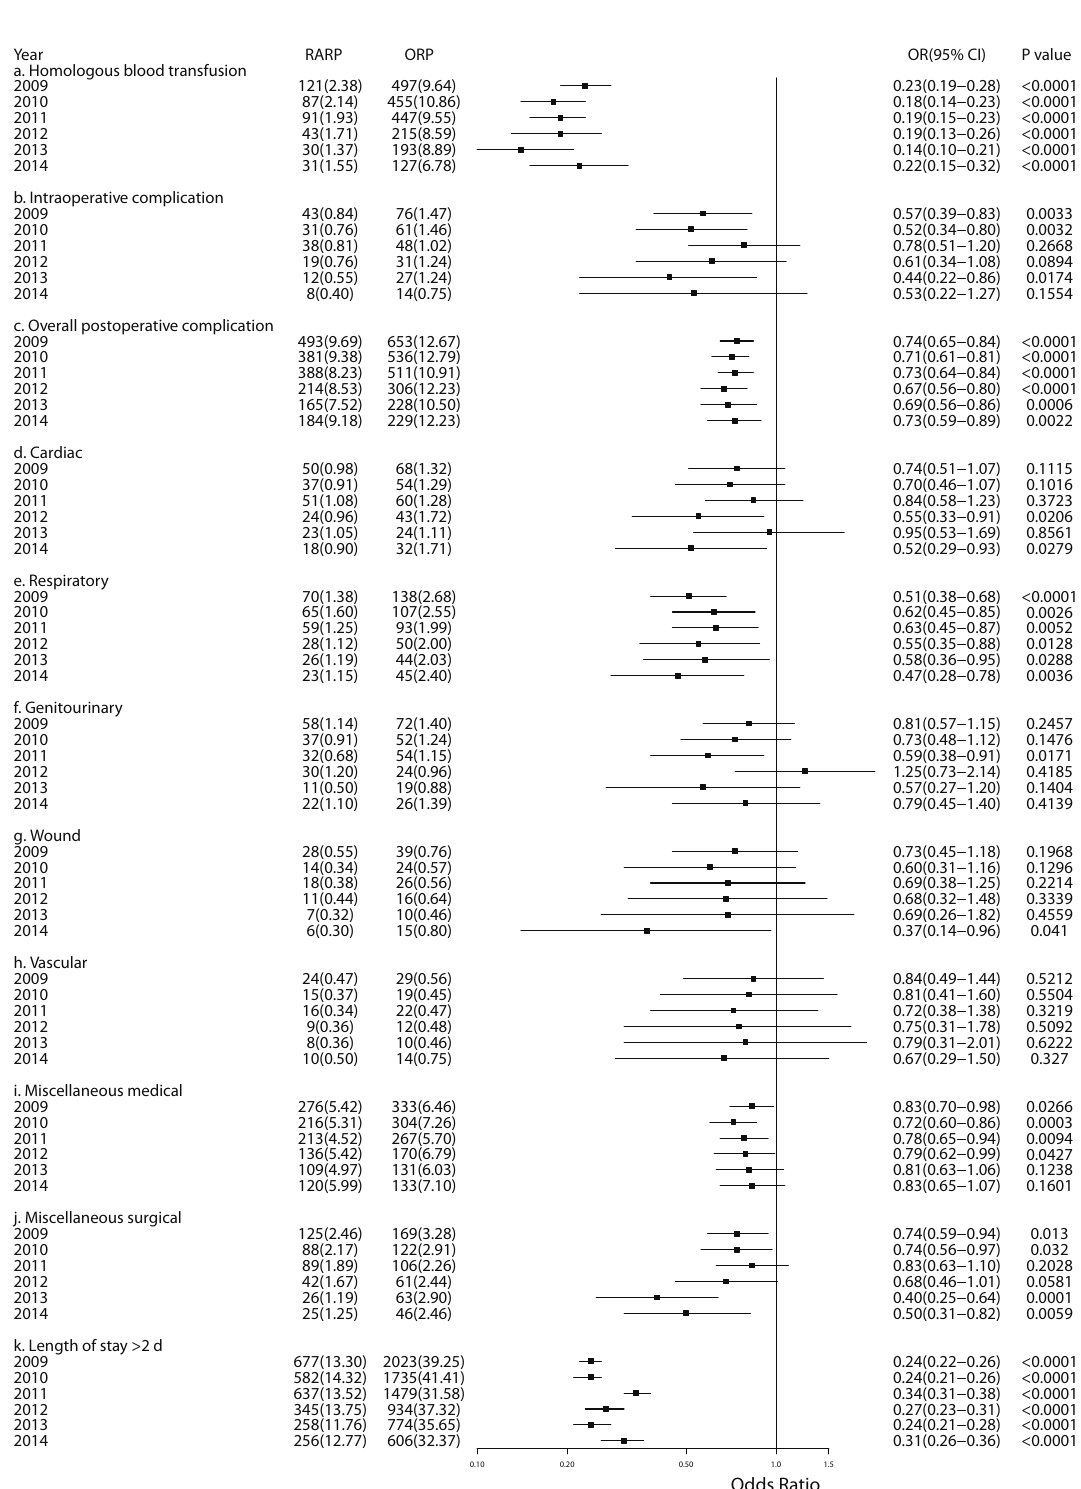
Figure 3 - The forest plot of odds ratios for the comparison between Robot-assisted Radical Prostatectomy group with the Open Radical Prostatectomy group from 2009 to 2014 (post-propensity score-matched